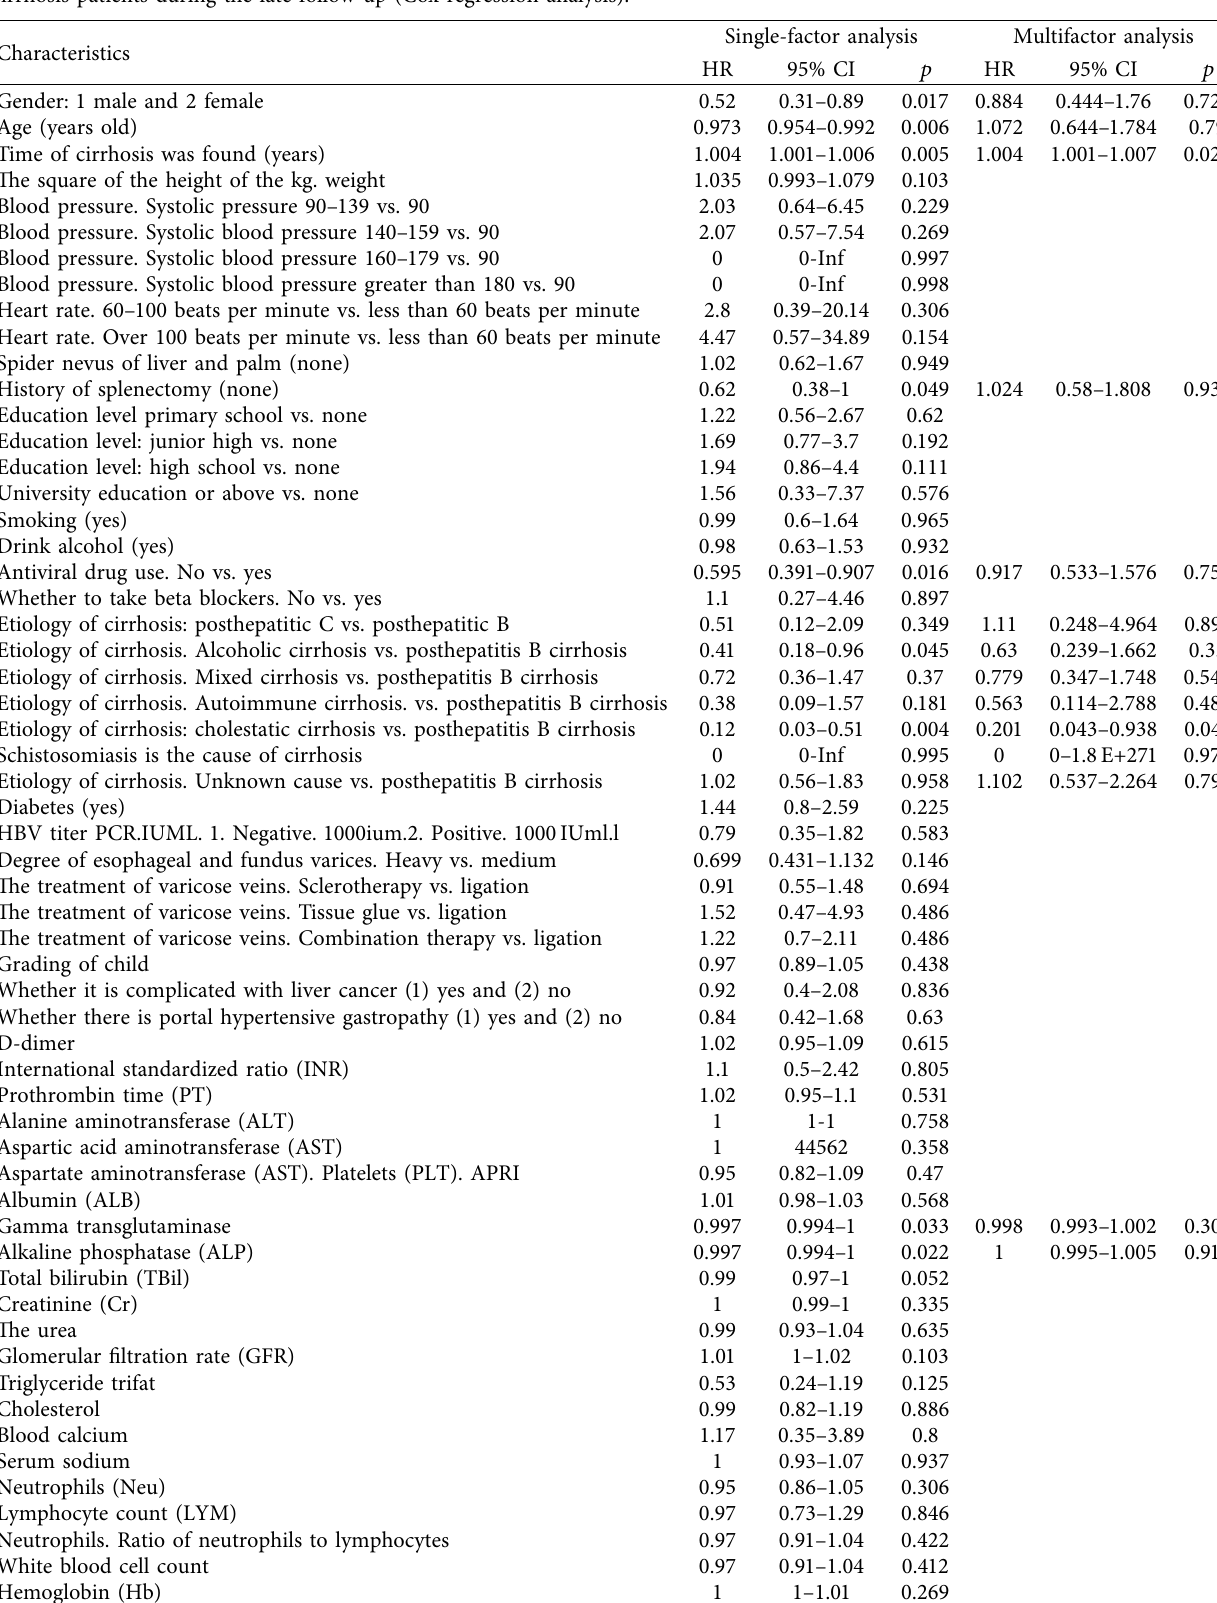
Table 3: Univariate and multivariate analyses of factors afecting the occurrence of portal vein thrombosis and/or cavernous lesions in liver cirrhosis patients during the late follow-up (Cox regression